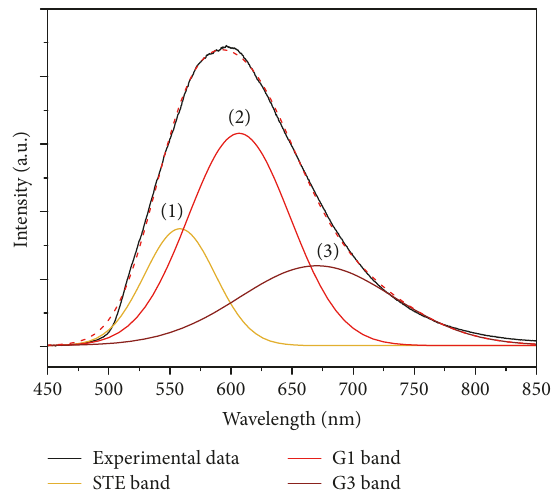
Figure 7: Fitting the separate PL bands that form the PL spectrum of PbCdI 2 thick films at 𝑇 = 300 K. Curves 1–3 correspond to STE, G1, and G3 bands, respectively. The red dashed curve represents the results of the fitting of the experimental data by the sum of Gaussian